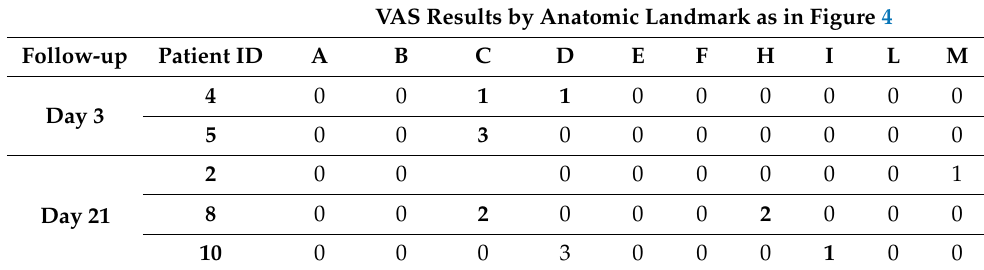
Table 1. Pain by Visual Analog Scale (VAS) during treatment.